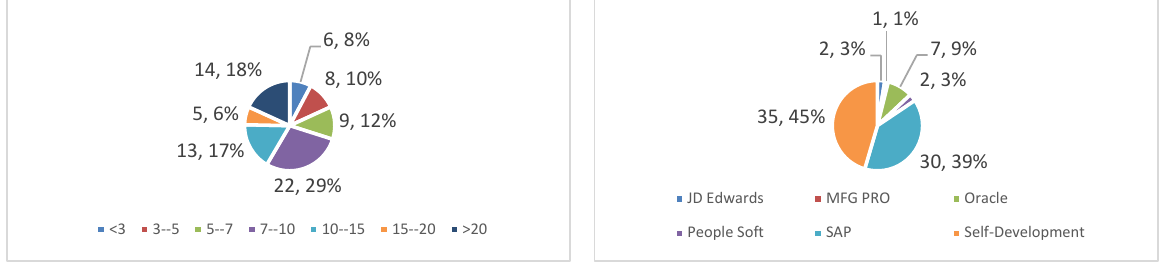
Fig. 2. Personal characteristics of the participants